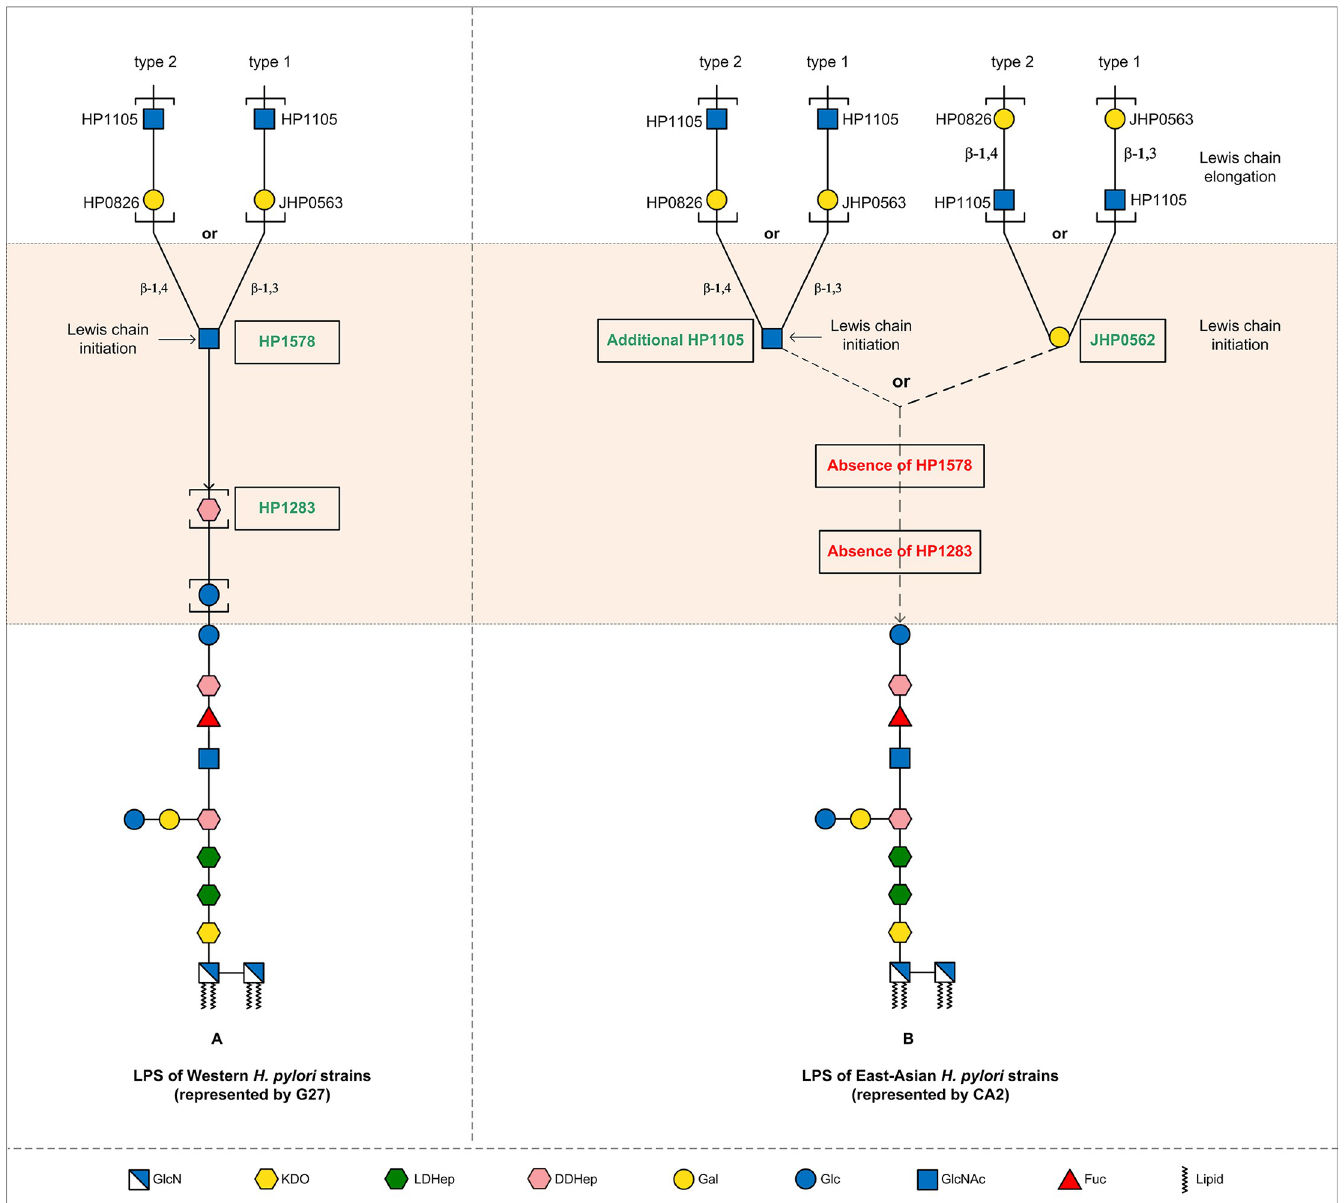
Fig 7. LPS biosynthesis model in H . pylori . The comparative genomic analysis of the LPS glycosyltransferase genes among H . pylori strains of different ethnic origin, provided genetic evidence for the structural conservation of the Glc-Trio-Core moiety of LPS, and the potential to express Lewis antigens in all H . pylori strains (Fig 4, S3 Table). However, the intermediate region (shaded) varies considerably between LPS from different H . pylori strains. ( A ): in Western strains (represented by G27) that harbour the heptan transferase gene HP1283 and the GlcNAc transferase gene HP1578 , the Lewis antigen synthesis is initiated by the GlcNAc transferase HP1578 onto the intermediate heptan (synthesized by HP1283); ( B ): in hspEAsia strains represented by the Japanese strains CA2 with its genome sequenced in this study showing the absence of HP1283 / HP1578 but the presence of two copies of HP1105 and one copy of JHP0562 (S3 Table column DS), and the established CA2 LPS structures lacking the intermediate heptan as reported in a previous study [19], the Lewis antigen is proposed to be directly attached onto the conserved Glc-Trio-Core structure via a GlcNAc or a Gal residue transferred by the additional HP1105 or JHP0562,